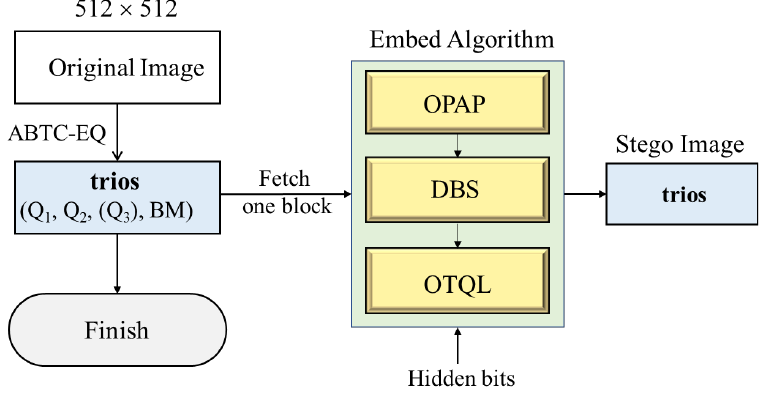
Figure 1. Schematic of the embedding